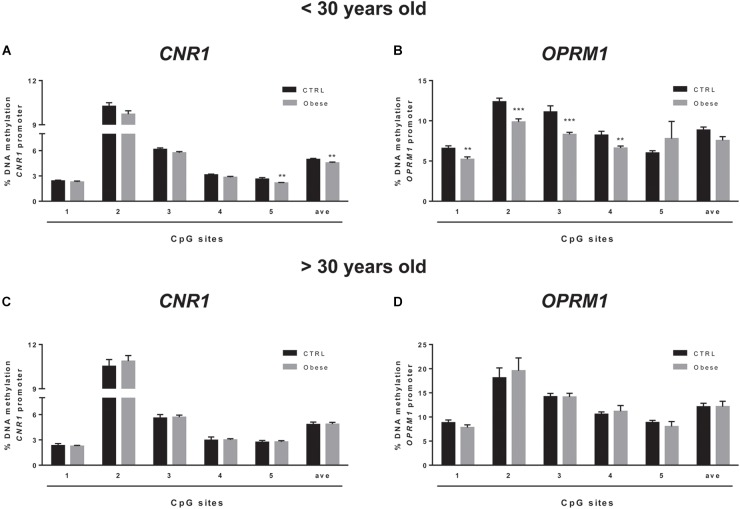
Comparison of DNA methylation status at human CNR1
(A,C) and OPRM1
(B,D) promoters in the obese population and control (CTRL) subjects stratified based on age (A,B = < 30 years old; C,D > 30 years old). The bars represent the mean of the % of methylation values of individual CpG sites under study as well as of the average (ave) of the CpG sites ± the SEM. Significant differences are indicated: ∗∗P < 0.01; ∗∗∗P < 0.001 vs. CTRL.